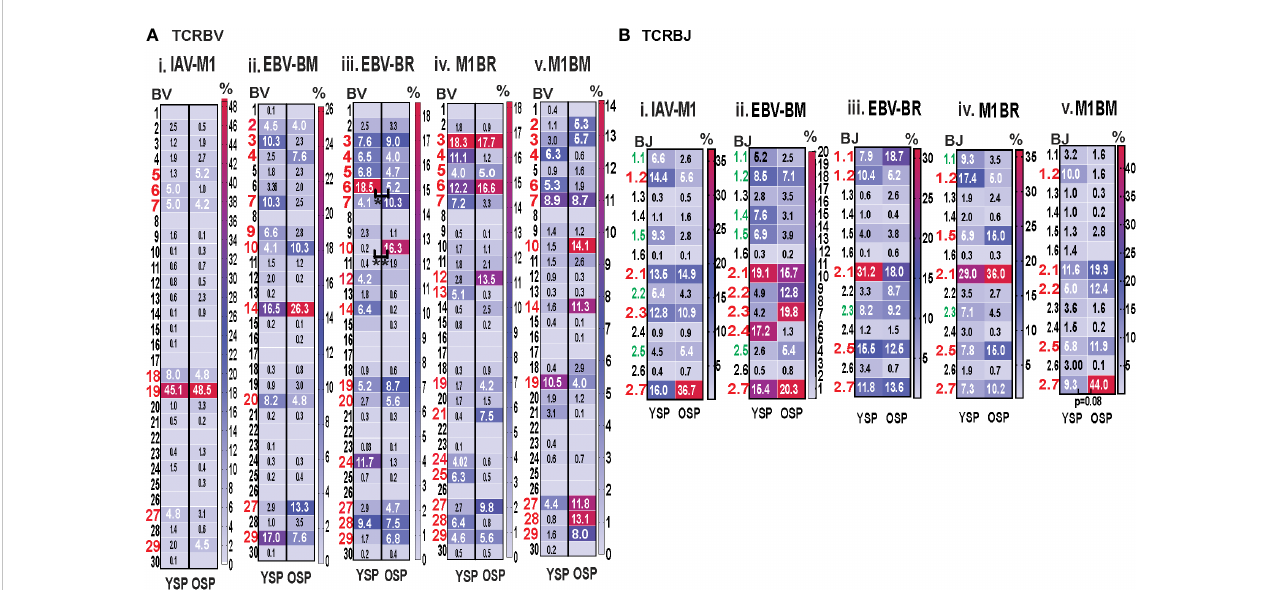
FIGURE 5 Signi fi cant differences in TRBV and BJ family usage in IAV and EBV-speci fi c and cross-reactive responses between young (Y) and older (O) donors. TRBV and BJ families determined for IAV-M1, EBV-BM, and EBV-BR cognate and cross-reactive responses in short-term cultured CD8 T cells that were tetramer-sorted and sequenced (Y n=4, O n=4-5). M1BM or M1BR are cross-reactive EBV-BM or EBV-BR single tetramer+ cells sorted from IAV-M1 stimulated short term cultures. (A) Heatmap analyses of TRBV (A) and BJ (B) family usage, showed signi fi cant differences in epitope-speci fi c responses between Y and O. Multi-variant 2-way ANOVA with adjusted p-value, *p < 0.05, **p < 0.01. (Also see Supplemental Table S3 for statistical